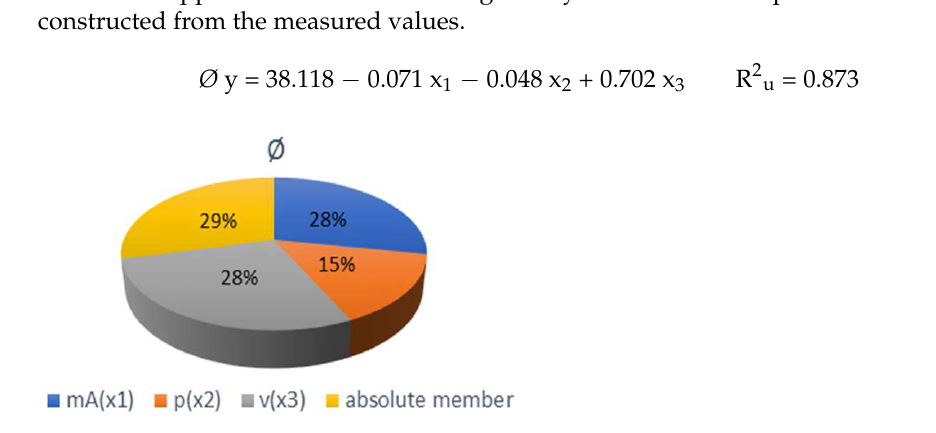
indicate an approximation of the curve given by the functional dependence to the curve